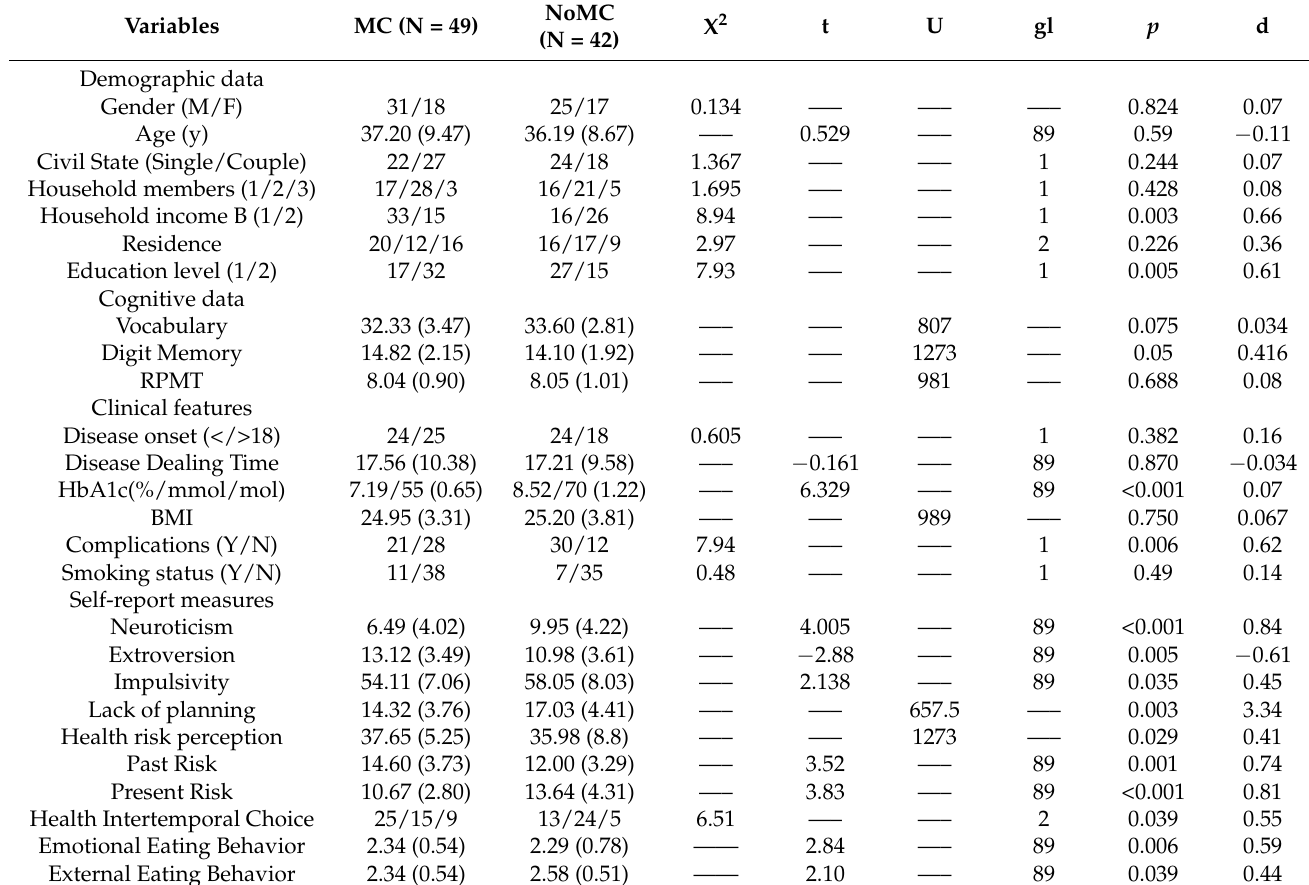
Table 1. Demographic characteristics, cognitive results, and relevant clinical features and self-report risk measures for NoMC and MC groups (N =